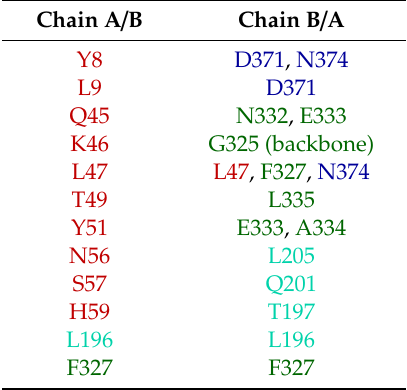
Table 1. Residues localized in monomer interaction